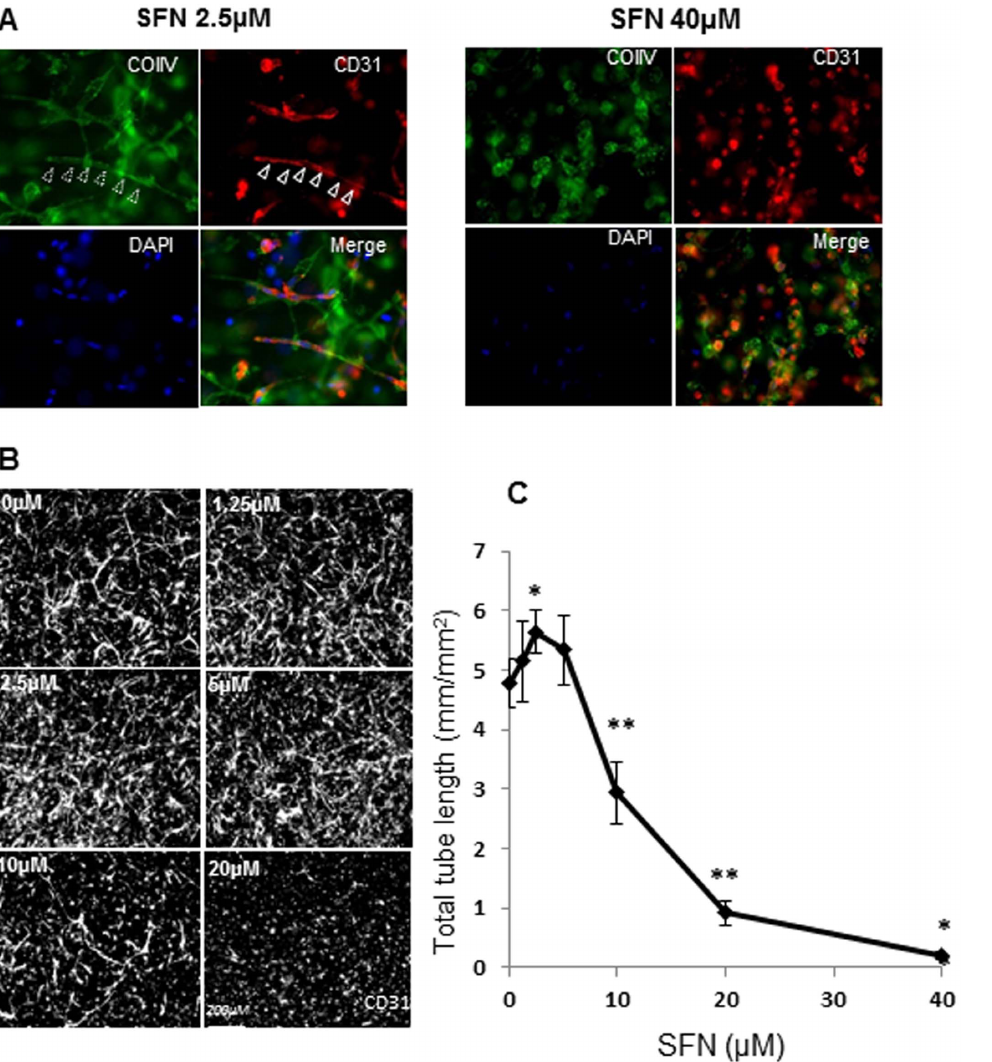
Fig. 5. Effect of SFN on endothelial tube formation in a 3-D angiogenesis assay. Culture medium supplemented with SFN (0–40 m M) was added to the top of 3-D collagen gels and then changed every 24 h with fresh SFN added. 3-D gels were fixed at day 5, immunostained with CD31 (red) and collagen type IV (green), and counterstained with DAPI (blue). (A): Low magnification pictures were taken from five random fields of each sample and calculated for average tube length. (B) Representative pictures are shown in triple staining with higher magnification. Data are expressed as mean ¡ SD (n 5 5) (C). *P , 0.05; ** P , 0.01 compared to untreated